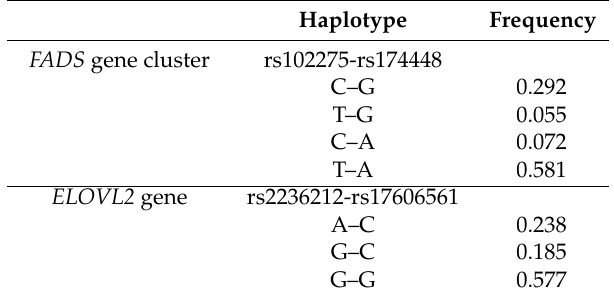
Table 8. Haplotypes of rs102275-rs174448 and of